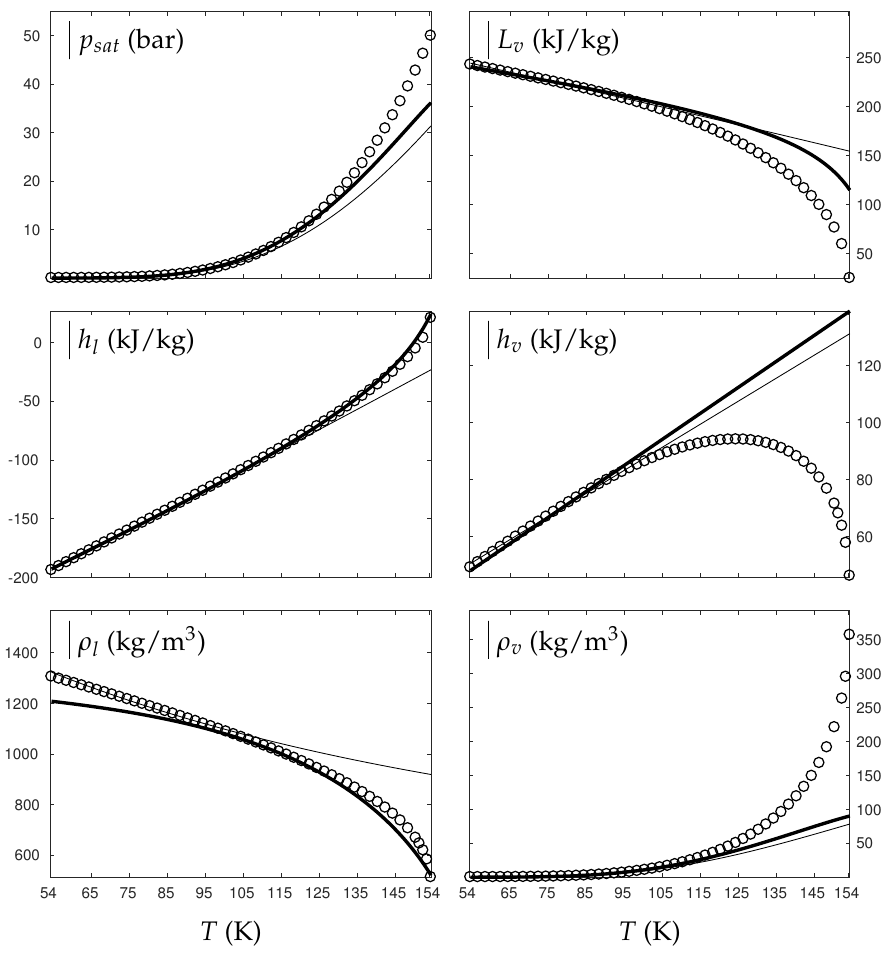
Figure 2. Comparison between experimental and theoretical saturation curves for liquid l and vapor v oxygen. Symbols represent experimental data. The thick lines represent the theoretical saturation curves obtained with the Extended NASG EOS (ENASG) reducing to the ideal gas description for the vapor phase, Equations (56) and (57). The thin lines represent results obtained with the original NASG EOS also reducing to the ideal gas formulation for the vapor phase. p sat denotes the saturation pressure, L v the latent heat, h the specific enthalpy and ρ the density.